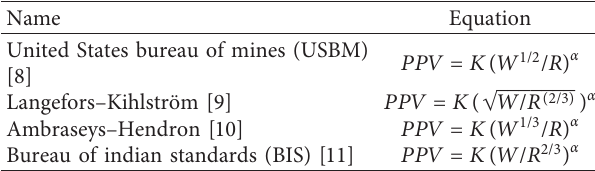
Table 1: Different conventional blast vibration equations